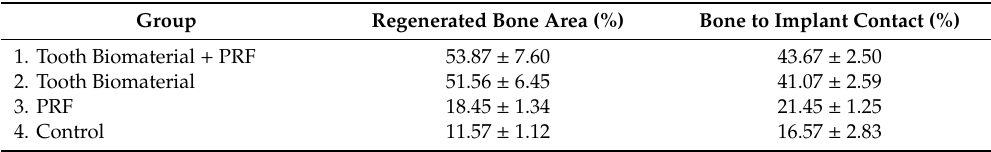
Table 1. Histomorphometric analysis.